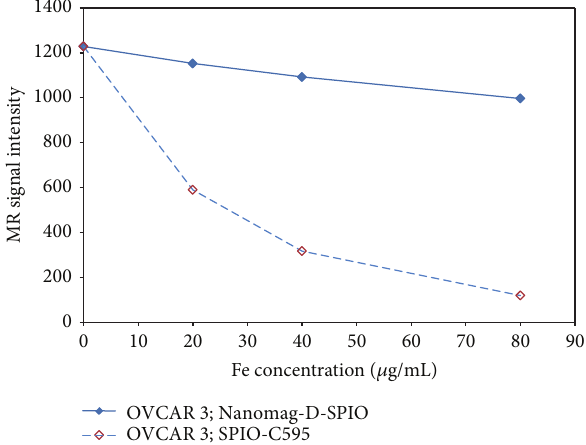
Figure 6: MR image signal intensity of both C595-SPIONs and Nanomag-D-SPIO at different Fe